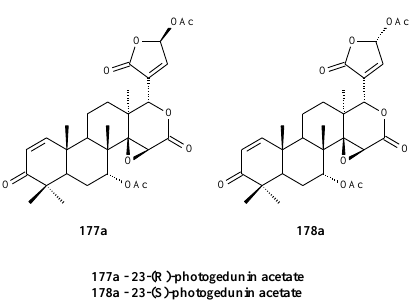
Figure 4. Derivatives of compounds 177 and 178 by Céspedes et al. [75].